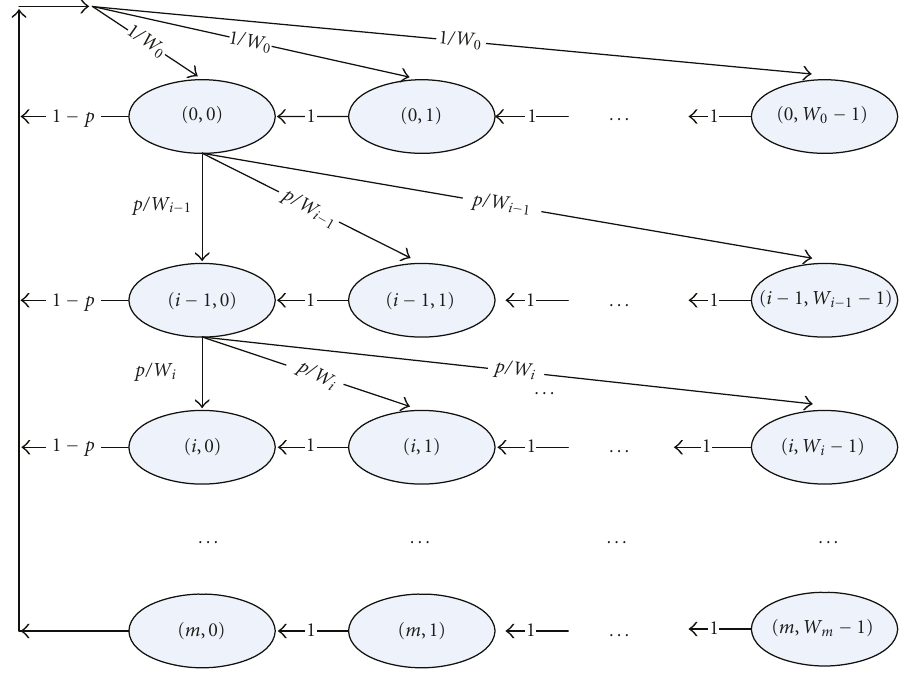
Figure 5: Wu’s Markov chain to model the backo ff window of the IEEE 802.11